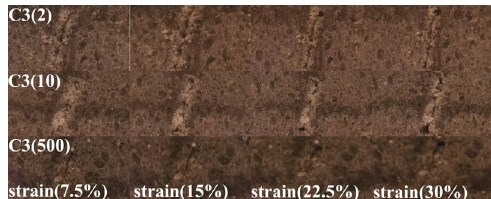
Figure 7: Microphotography (MP) results for group C3 (75 ° crack).